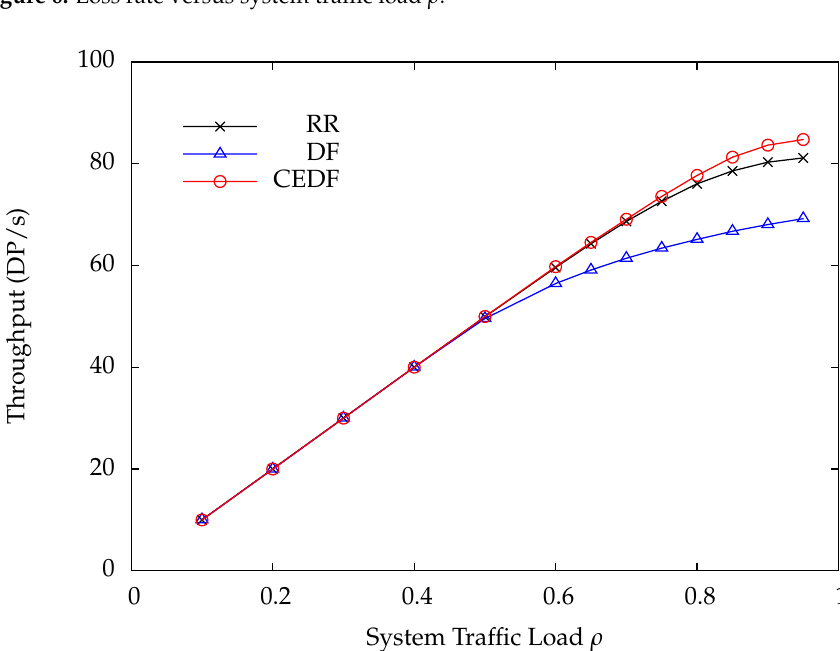
Figure 7. Throughput versus system traffic load ρ